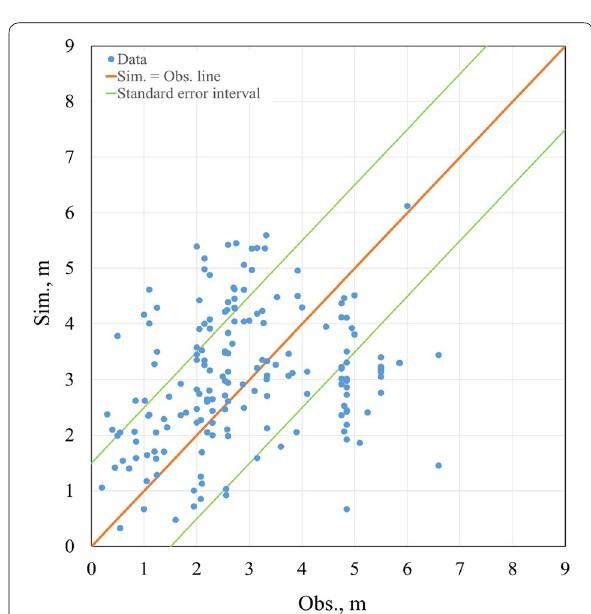
Fig. 15 Scatter plot between the observed and simulated data (from the best-fitting parameters) for the maximum flow